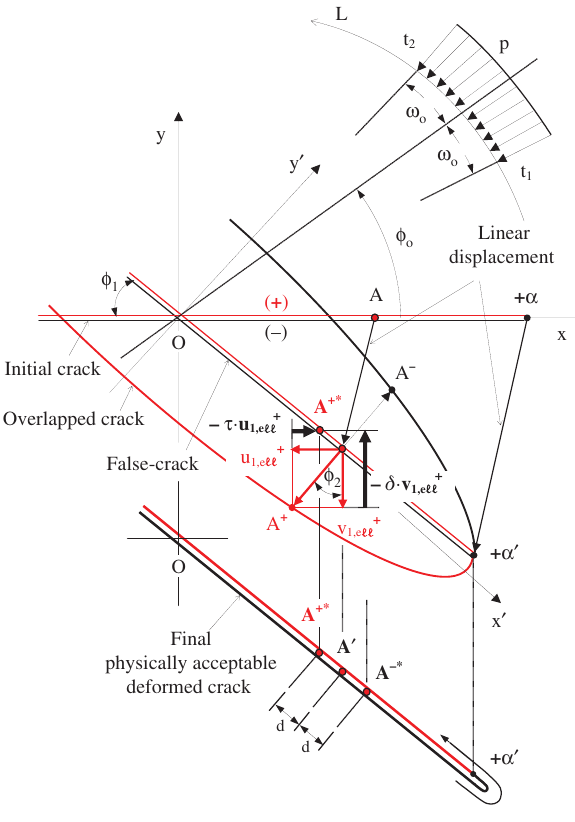
Figure 4 The confrontation of the overlapping and the physically acceptable deformed crack (out of